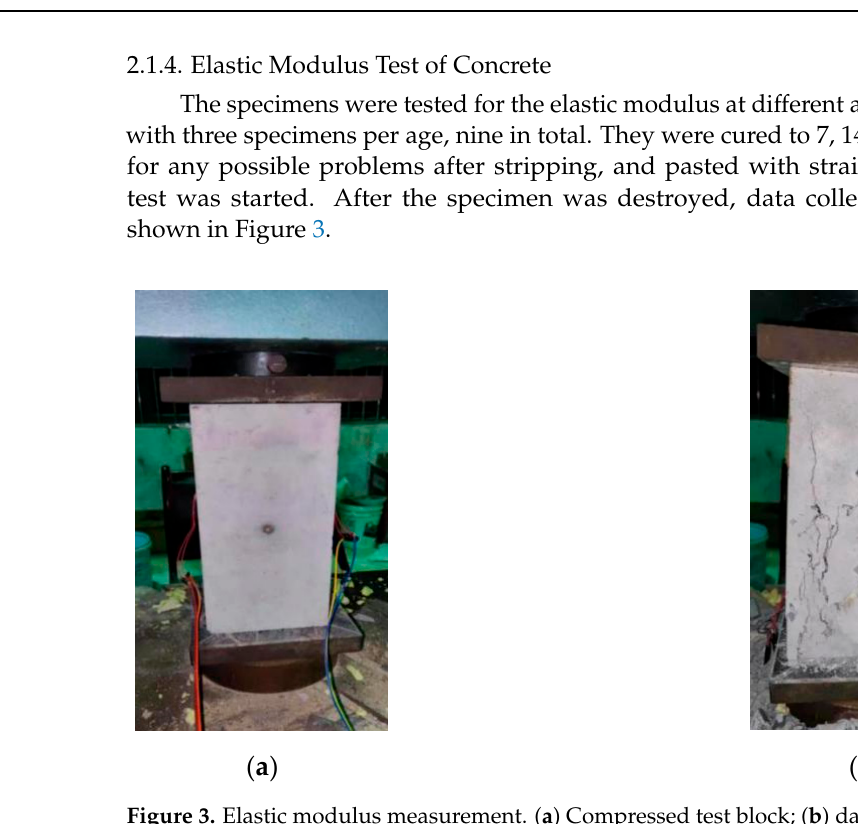
Table 1. Compressive strength of C35 concrete at different ages.